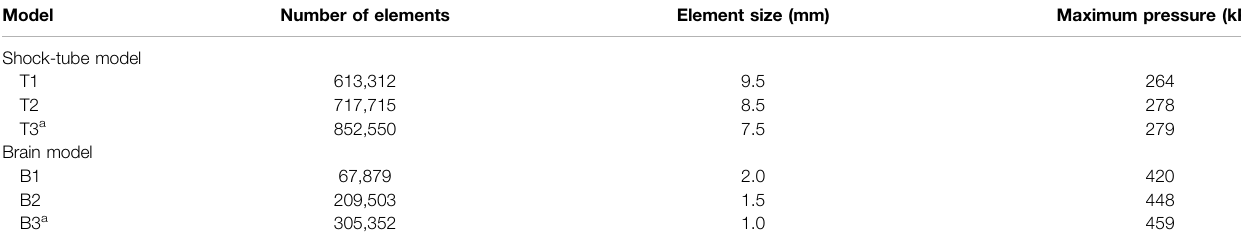
TABLE 2 | Summary of the mesh-sensitivity tests performed on the shock-tube model and the minipig-brain model.